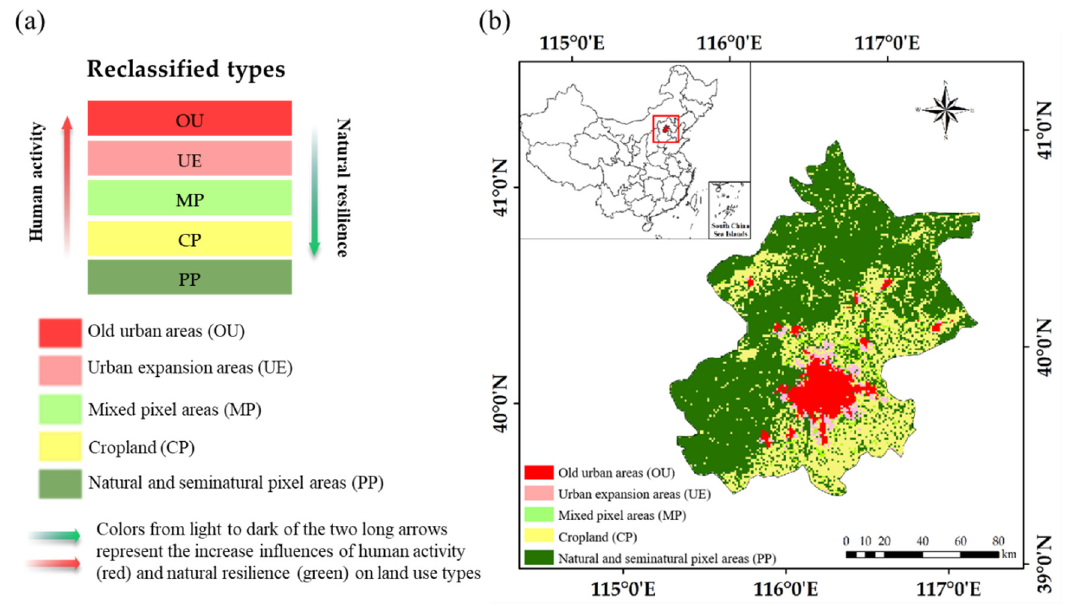
Figure 1. Land use reclassification ( a) and spatial distribution of land use types ( b ) in Beijing in 2015.